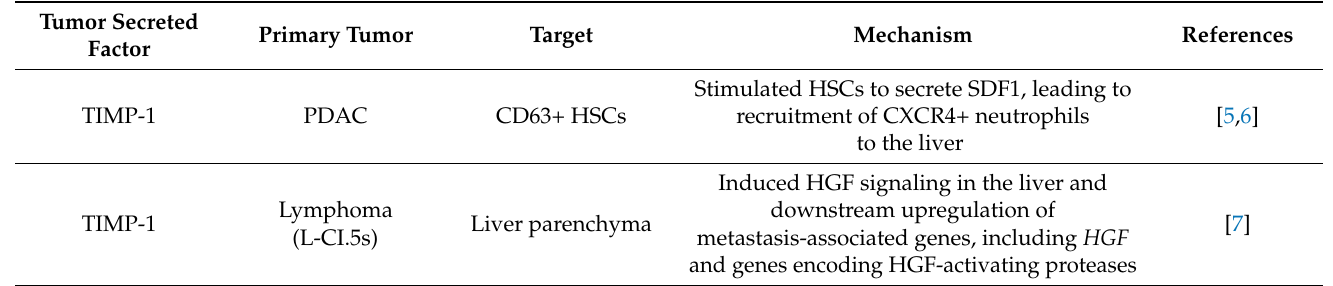
Table 1. The list of primary-tumor-derived molecular components and associated mechanisms involved in the development of the hepatic